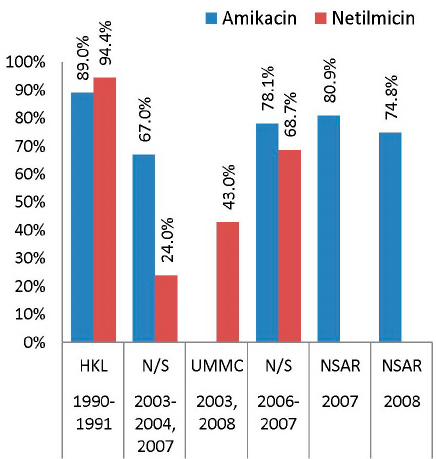
Figure 2. The prevalence of amikacin and netilmicin resistance among Malaysian MRSA isolates, 1990–2008. Data from the NSAR reports; HKL between 1990 and 1991 [13]; not specified (N / S) between 2003 and 2004 and in 2007 [16], and between 2006 and 2007 [17]; and UMMC in 2003 and 2008